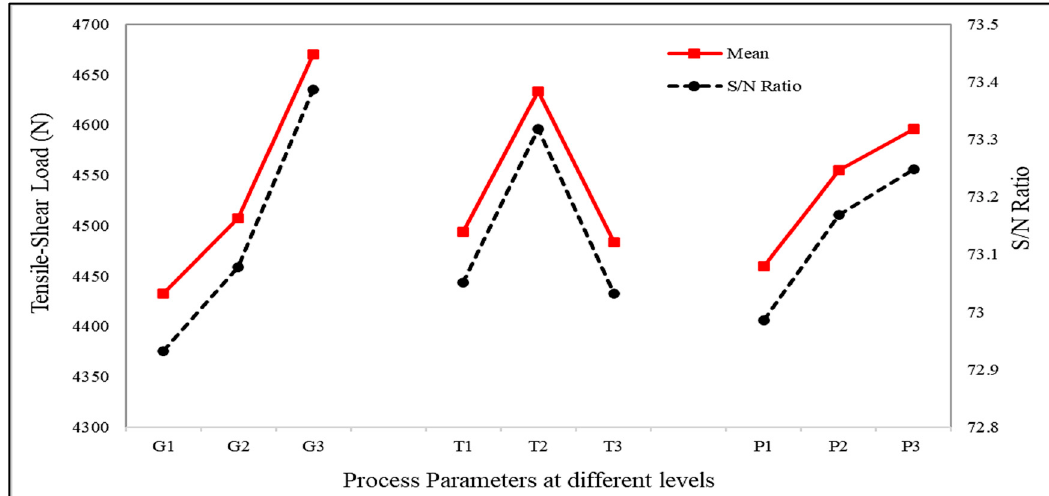
Figure 7. Effects of the process parameters on tensile–shear load.